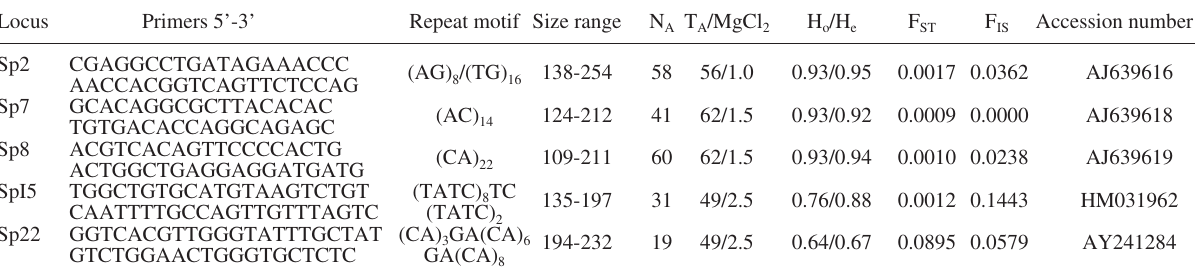
Table 2. – Characterization of the microsatellite markers of sardine used in this study. N MgCl , concentration in mM; H 2